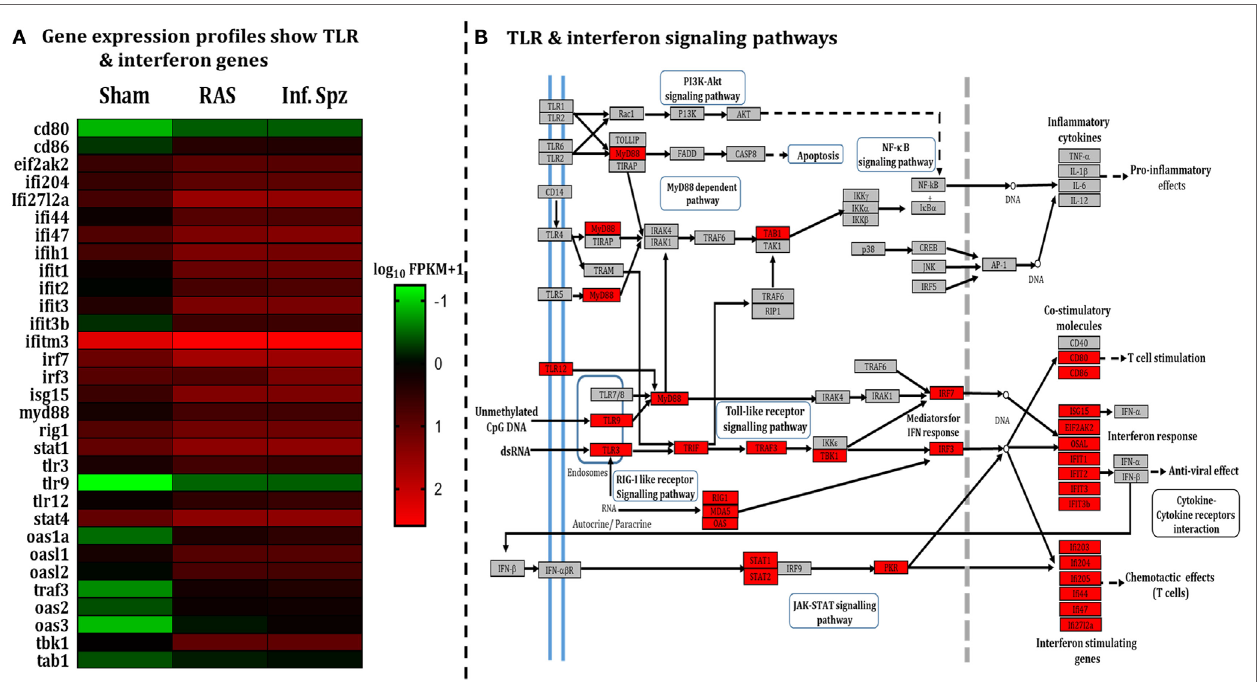
FigUre 2 | Assessment of liver microenvironment through whole-genome RNA Seq. (a) Heat map showing differential gene expression in mouse liver post 72 h following 50K radiation-attenuated sporozoites (RAS) or 10K infectious sporozoites (Inf. Spz) inoculation. (B) Enriched pathway in Kyoto Encyclopedia of Genes and Genomes (KEGG) database: significantly differentially expressed genes identified by KEGG as involved in toll-like receptor signaling and interferon signaling. Red, significantly increased expression (fold change > 1); grey, unchanged